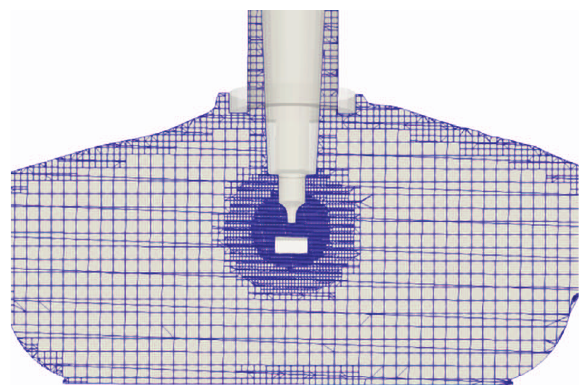
Fig. 6. Engine computational grid during ignition with the re fi ned regions around the spark plug, piston, and pent roof visible. The grid size away from the spark plug gap and the cylinder and cylinder head walls is 1 mm.